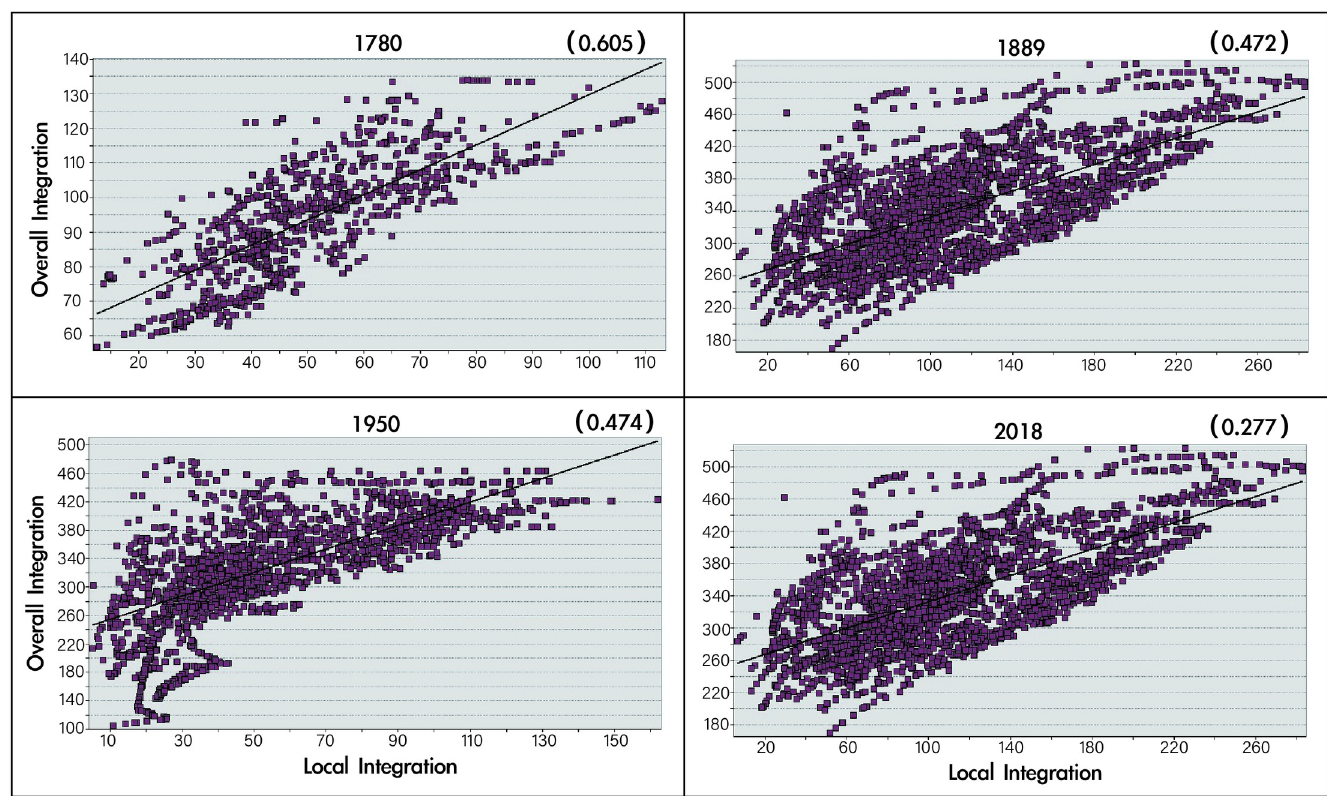
Fig 6. Numerical analysis of intelligibility of the Macau Peninsula in 1780, 1889, 1950, and 2018.